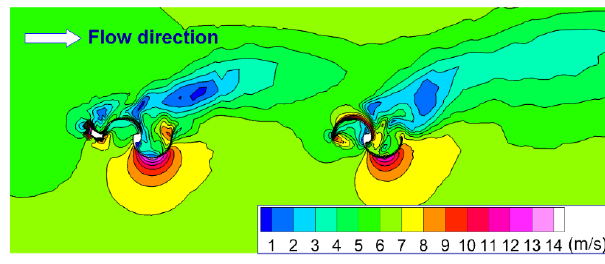
Figure 9. Flow velocity distribution near the upstream and downstream rotors.